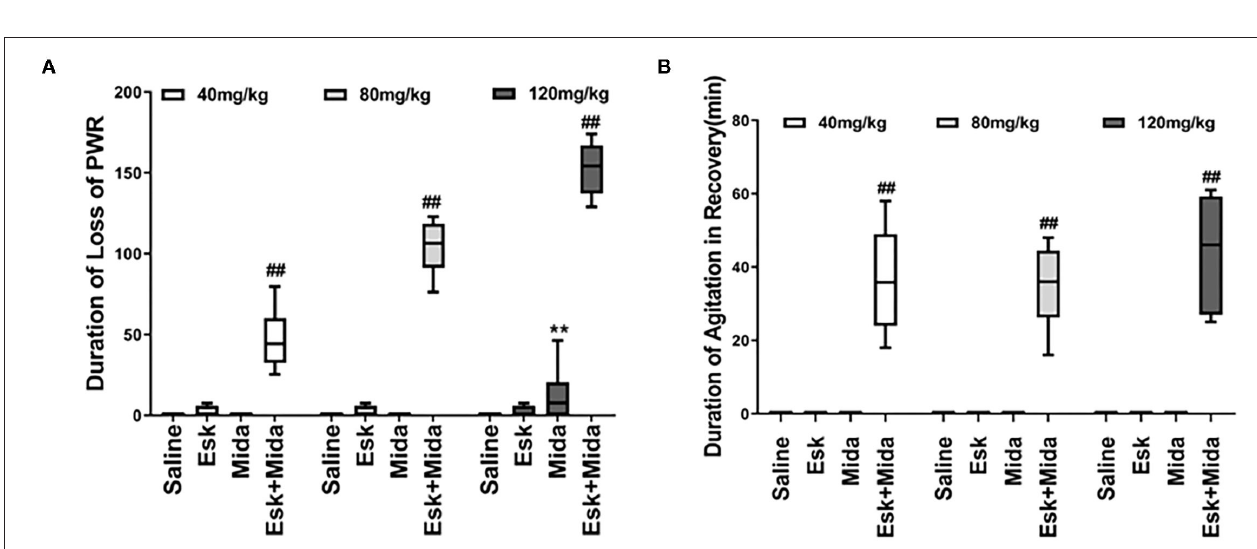
FIGURE 3 | Duration of loss of PWR and duration of agitation during the recovery after injection. (A) Duration loss of paw withdraw reaction. ## P < 0.01, compared to Esk, Mida, and Esk + Mida groups. ** P < 0.01, compared to Esk groups. (B) Duration of agitation during the recovery. ## P < 0.01, compared to Saline, Mida, and Esk